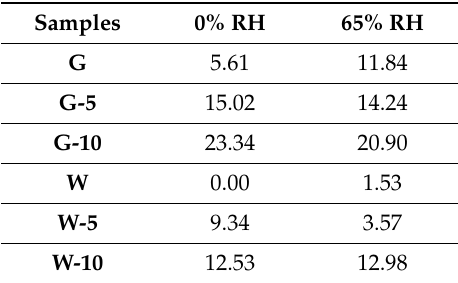
Table 5. NOx removed (%) according to di ff erent study